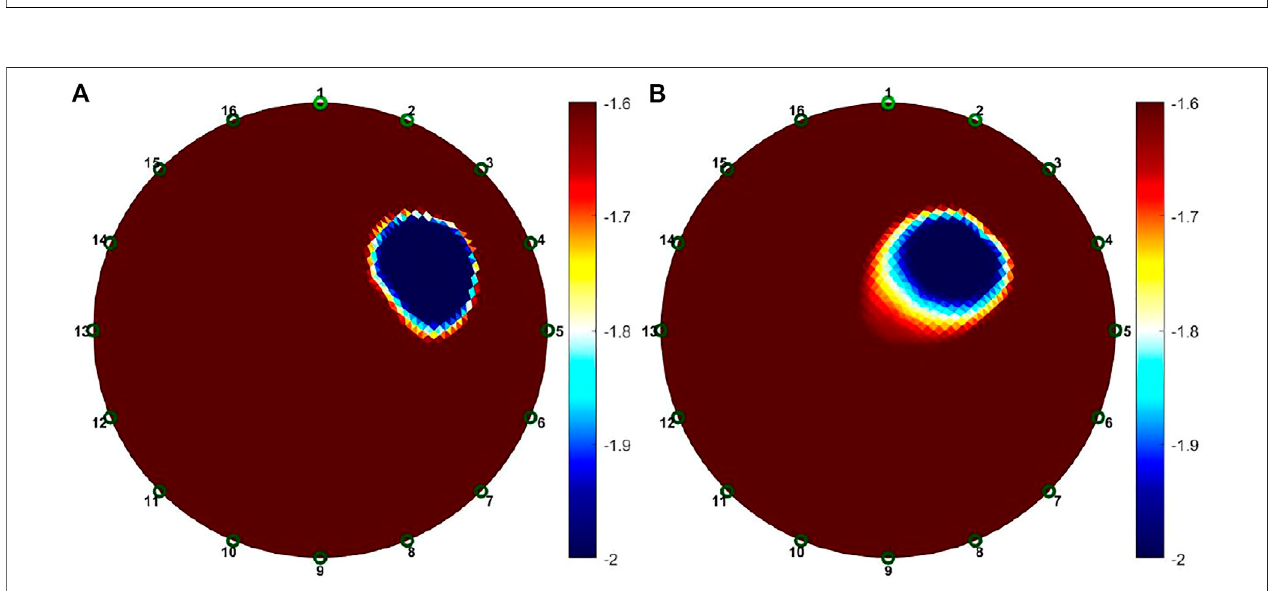
FIGURE 10 | Reconstruction of the saline- fi lled phantom using data obtained by (A) AM (hand selection) and (B) AX (multiplexed corrected using the second method). QF = 67.